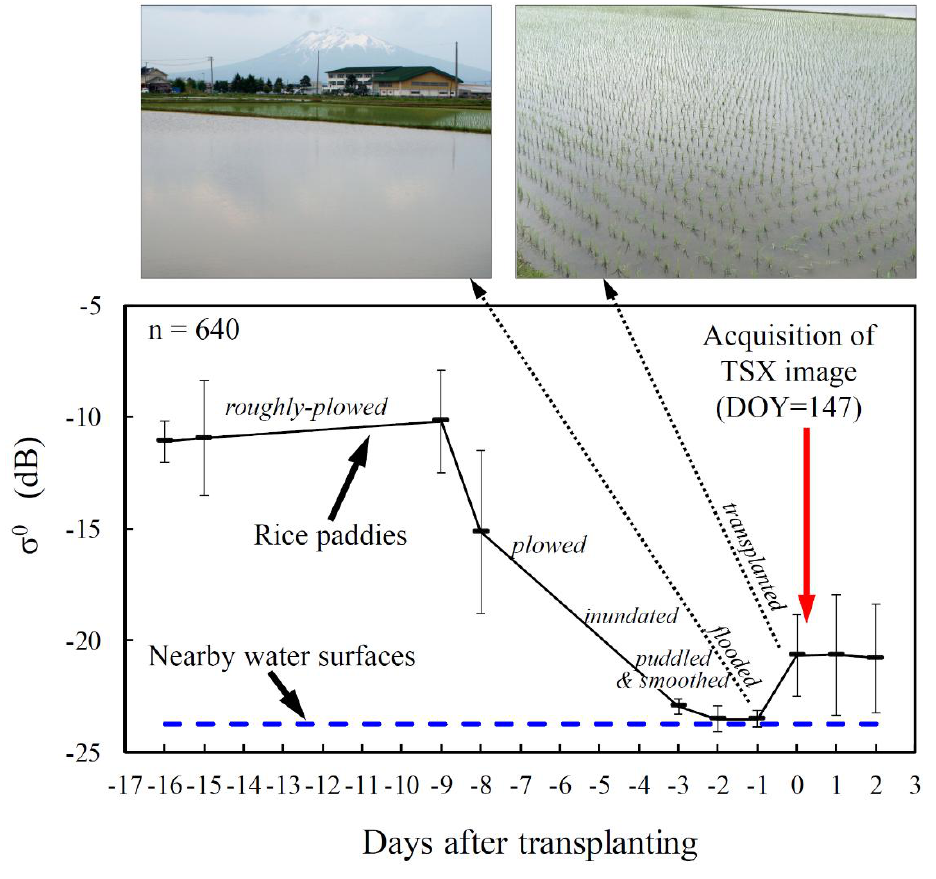
Figure 3. The σ 0 values for various conditions of rice paddies plotted on the axis of days after transplanting (DAT). Date of transplanting was identified for 640 rice paddy fields within the image taken by TSX on 26 May 2012 (DOY 147). For example, fields for DAT +1 and −1 were under the conditions a day before and after transplanting, respectively. Upper pictures show the typical situation for the fields observed on